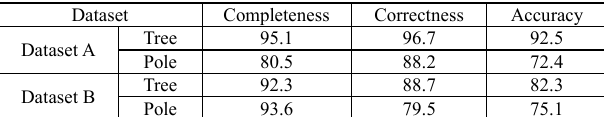
Table 1: Evaluation result of on pole-like object detection based